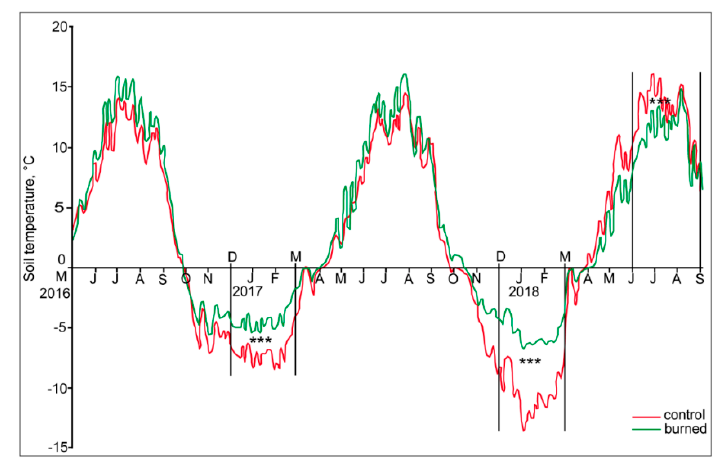
Figure 2. Daily average soil temperature at 5 cm depth during the 3-year decomposition experiment.